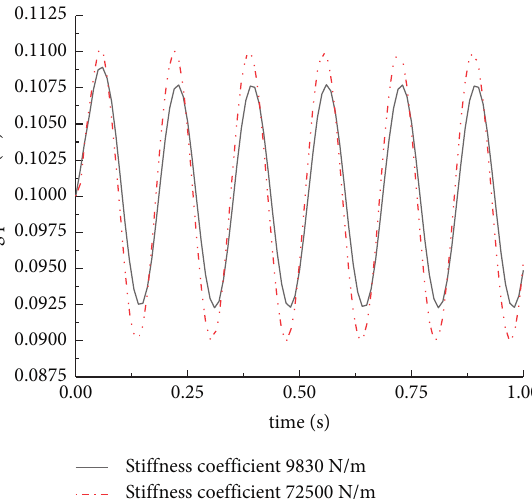
Figure 15: The displacement of branch 1 (constant damping coefficient 100 N ·